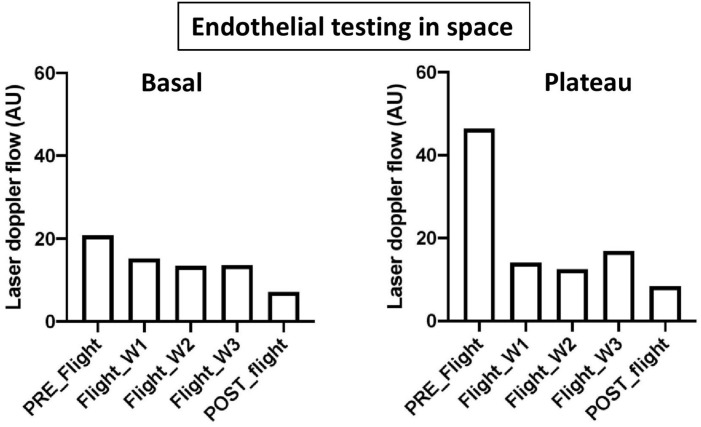
ACh testing with iontophoresis at the forearm skin level in two astronauts during the Tiangong -2 3-week space flight (W1, W2, W3). Basal, skin blood flow before ACh stimulation; Plateau, plateau phase of endothelium-dependent vasodilation after ACh stimulation. Data are mean values.